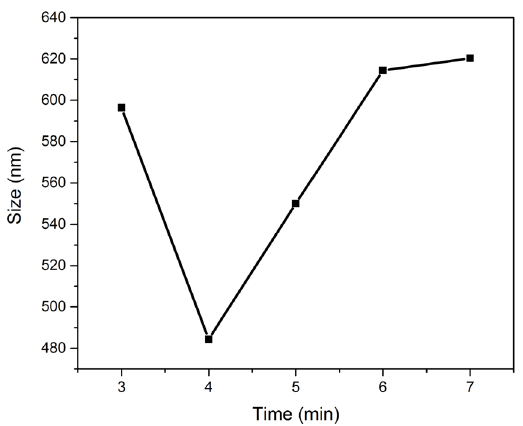
Figure 9: E ff ect of ultrasonic time on the particle size of BSA/AM microcapsules.